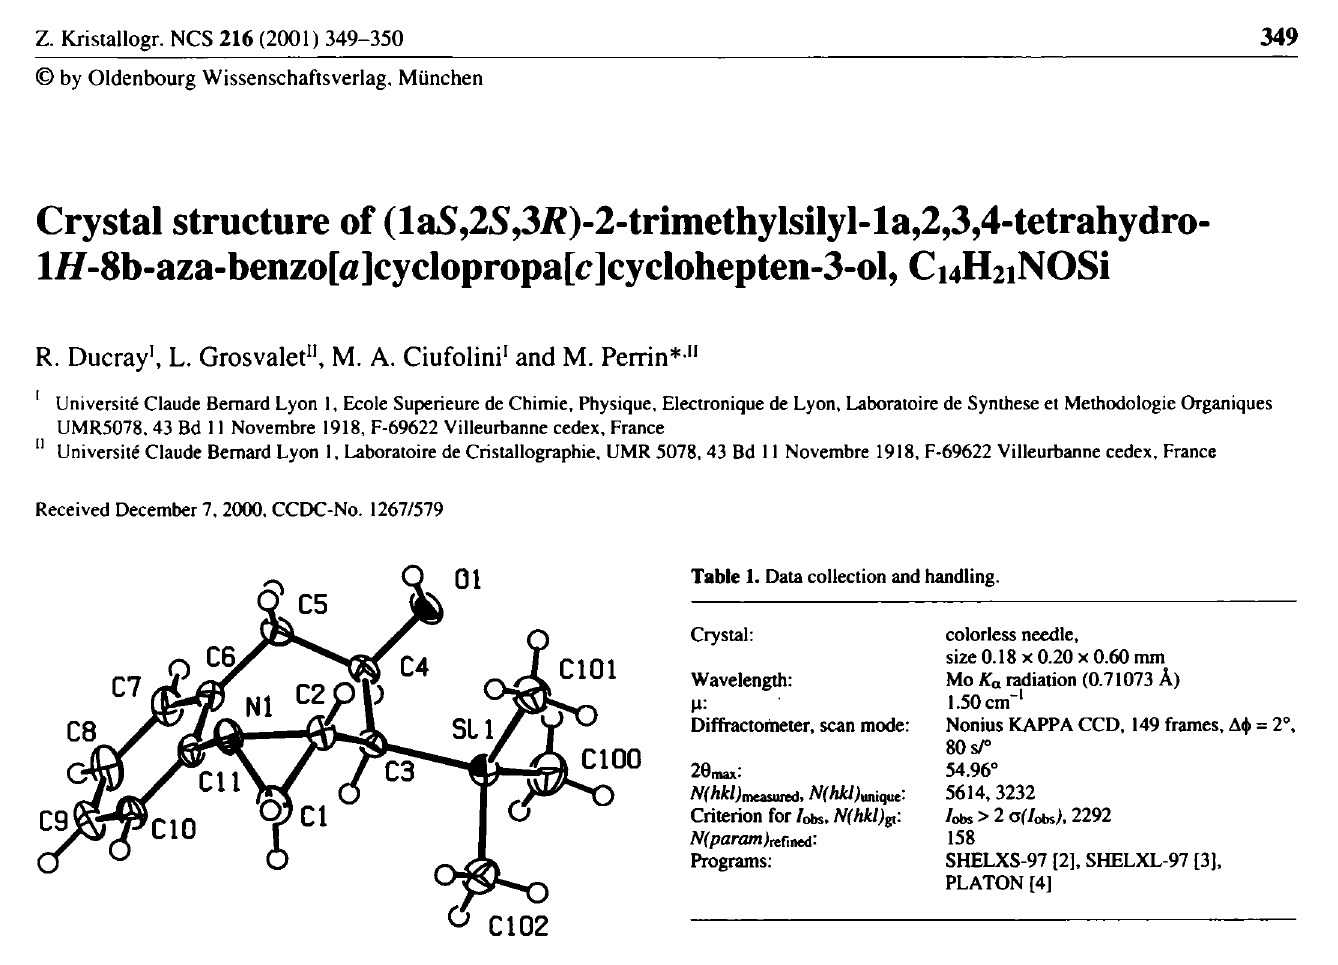
Table 2. Atomic coordinates and displacement parameters (in A 2